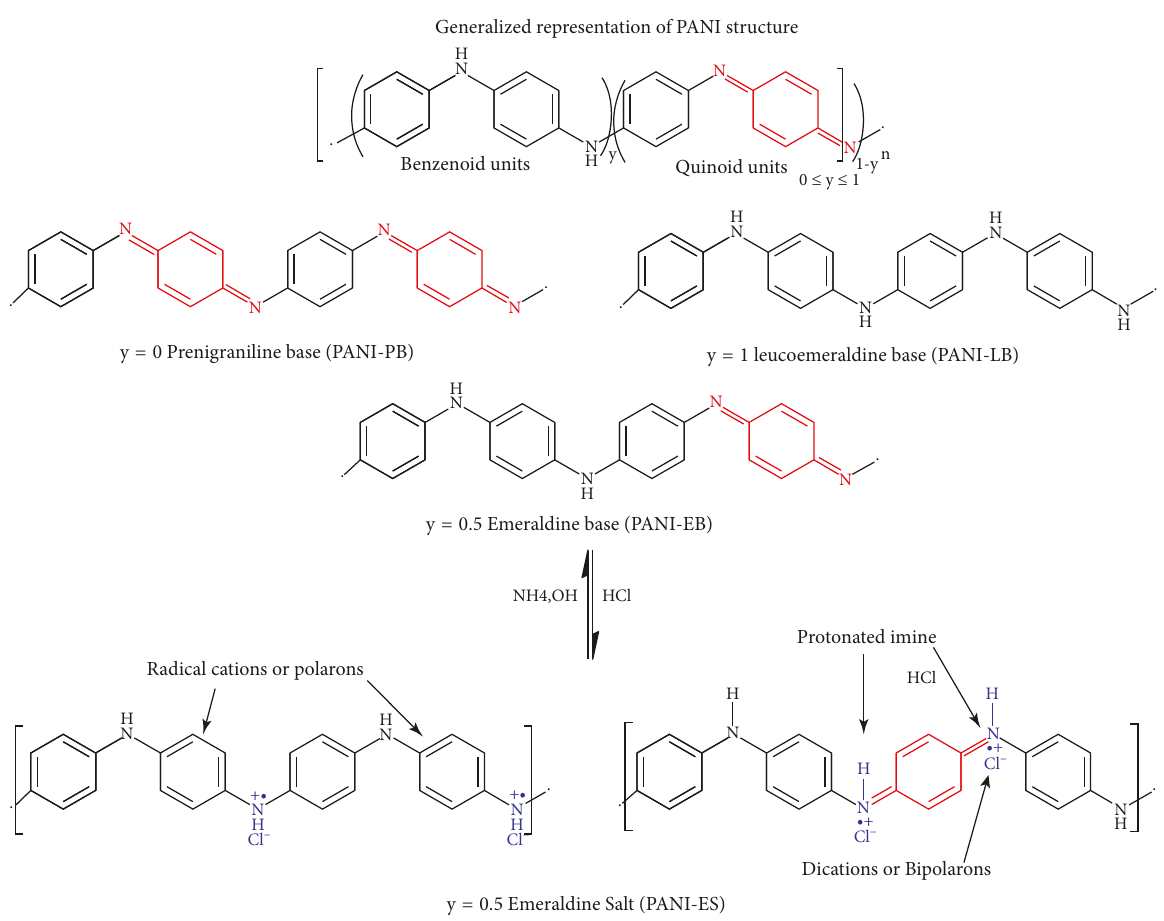
Figure 9: Chemical structures of polyanilines.